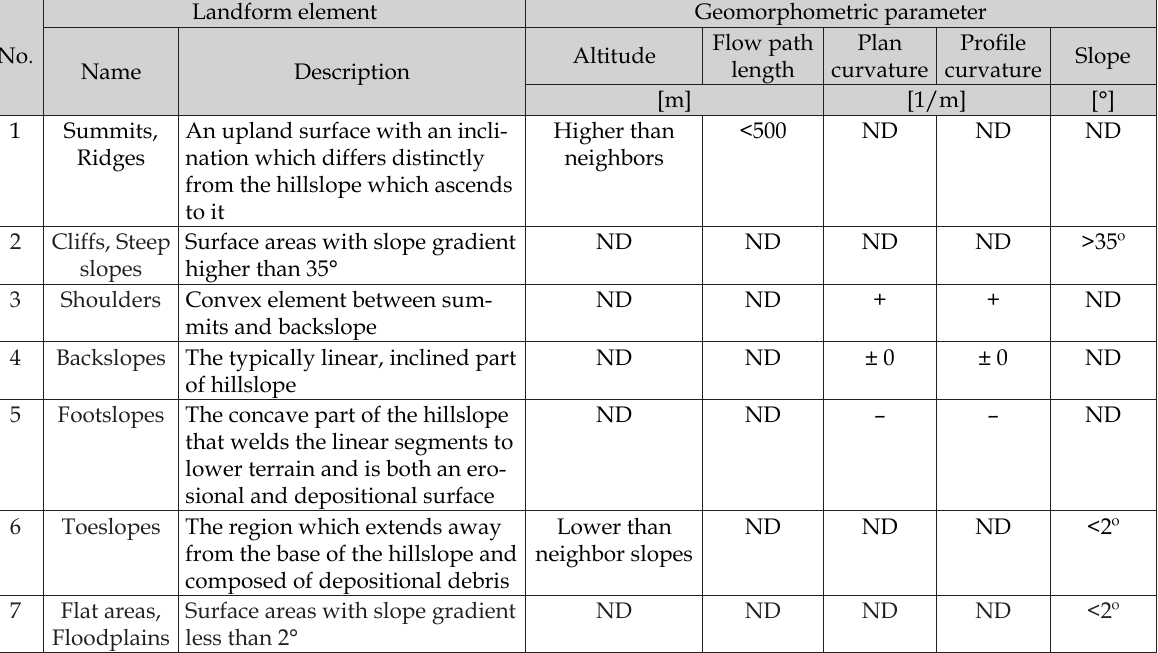
Fig. 3. Fundamental local landform elements based on plan and profile curvatures. 1 – “shoulders”, 2 – “backslopes”, 3 – “footslopes”. Arrows indicate possible combinations in classification (modified after Dikau Table 3. Geomorphometric parameters used in landform classification.